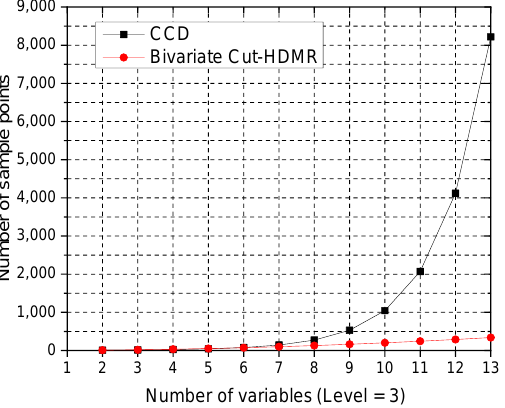
Figure 4. Numbers of sample points required by Bivariate Cut-HDMR and CCD as a function of the number of variables. Table 4. Number of sample points required for Central composite design (CCD) and Bivariate Cut HDMR with s =